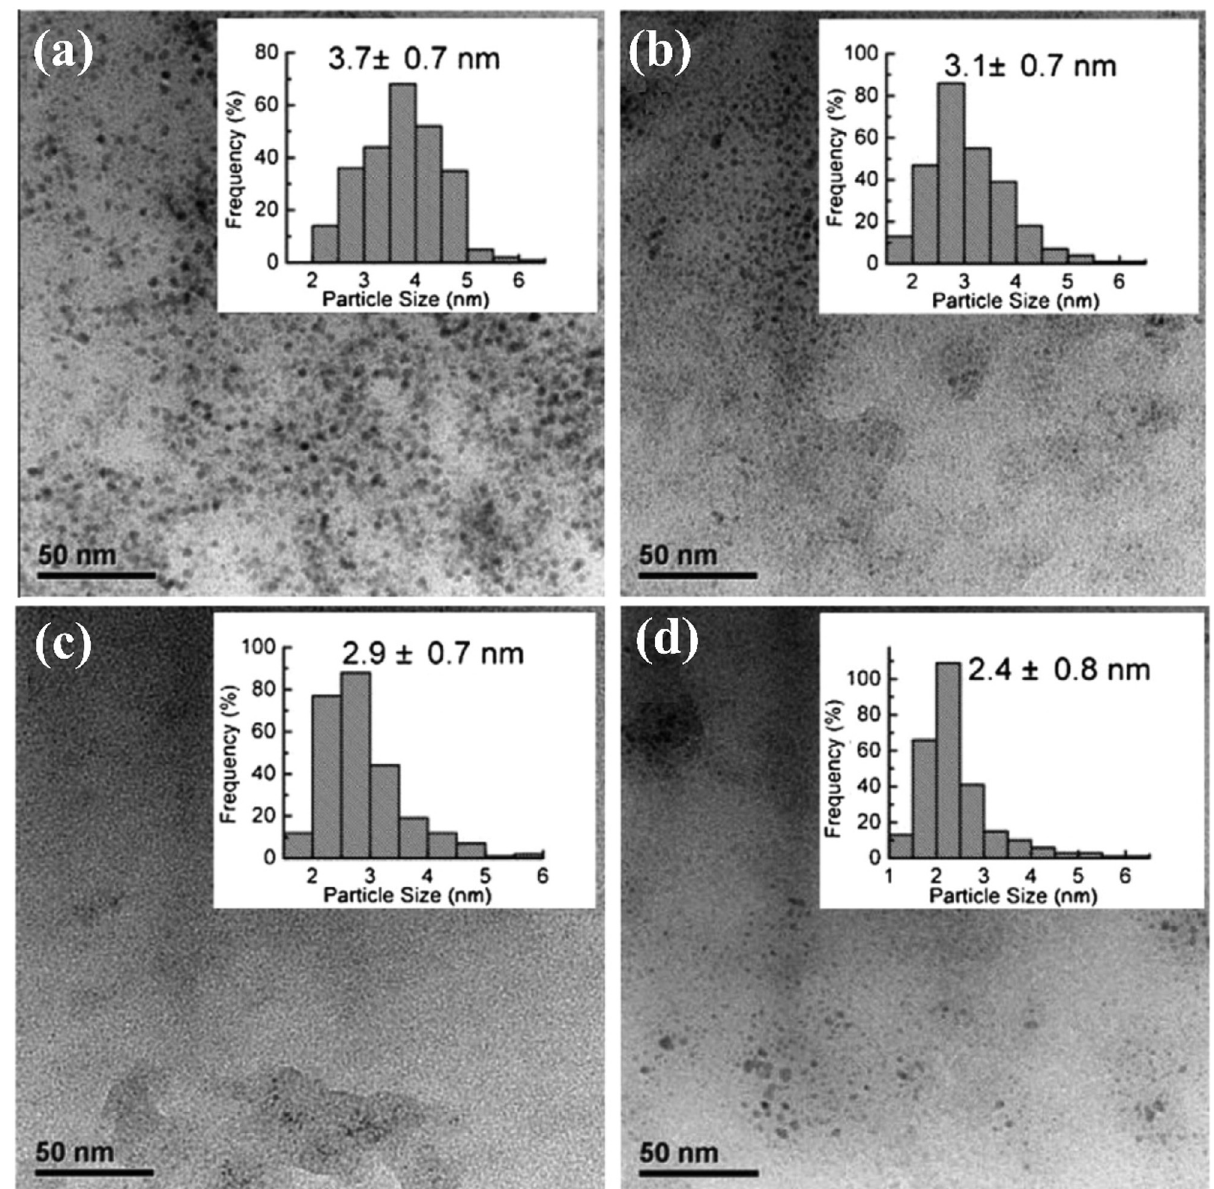
Figure 7: TEM images of the Pt NPs synthesized under di ff erent percentages of CPE: ( a ) 10%, ( b ) 30%, ( c ) 50%, and ( d ) 70% for reaction temperature of 90°C and preliminary Pt ( II ) concentration of 0.5 mM ( reprinted from ref. [ 12 ] , copyright 2020, with permission from Elsevier )